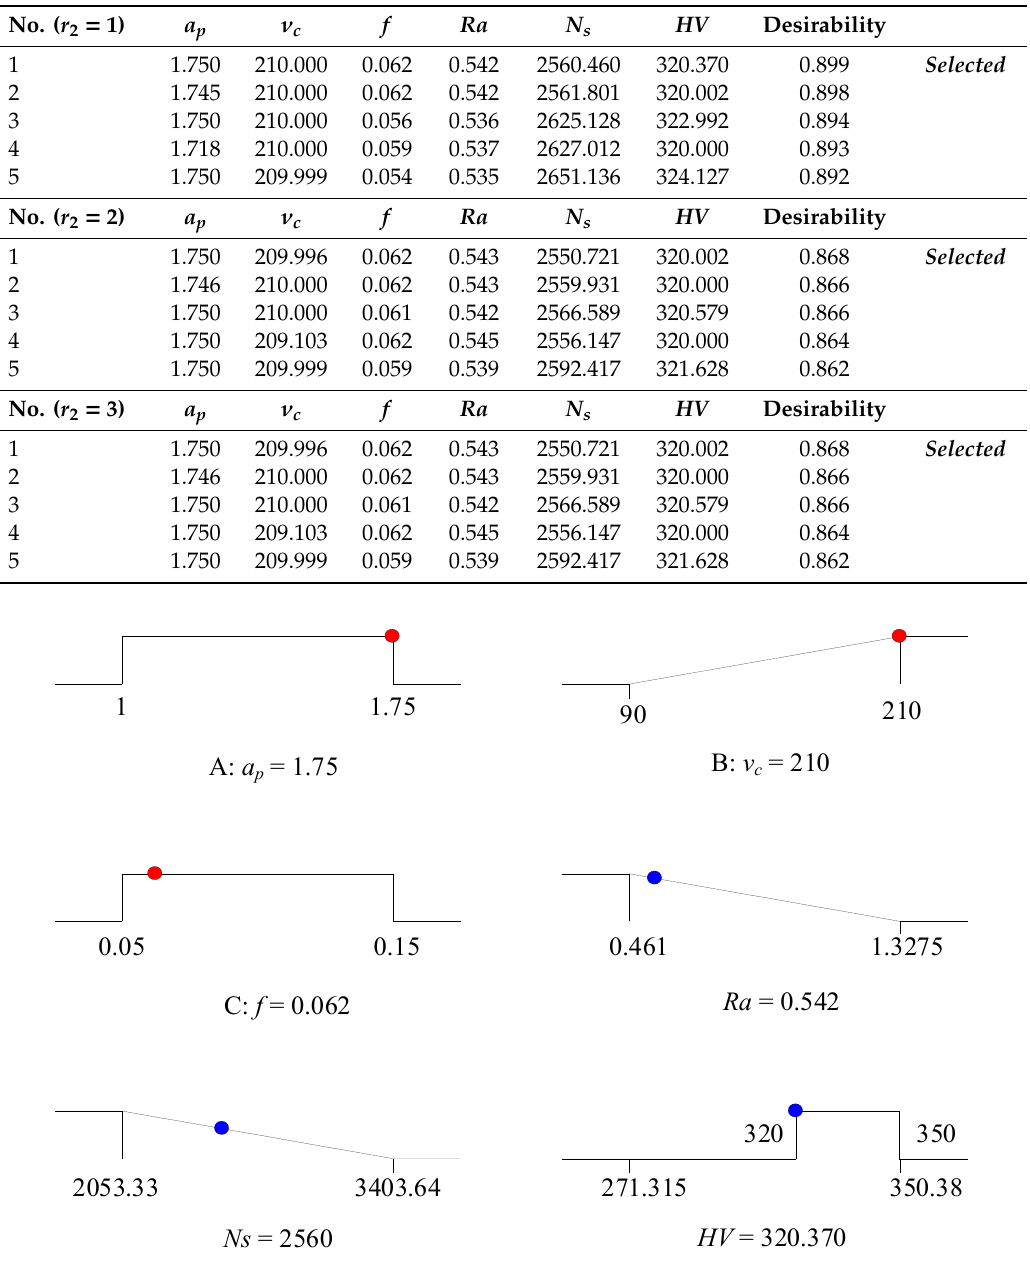
Table 11. Multi-objective optimization solution (low surface roughness (LSR) mode).